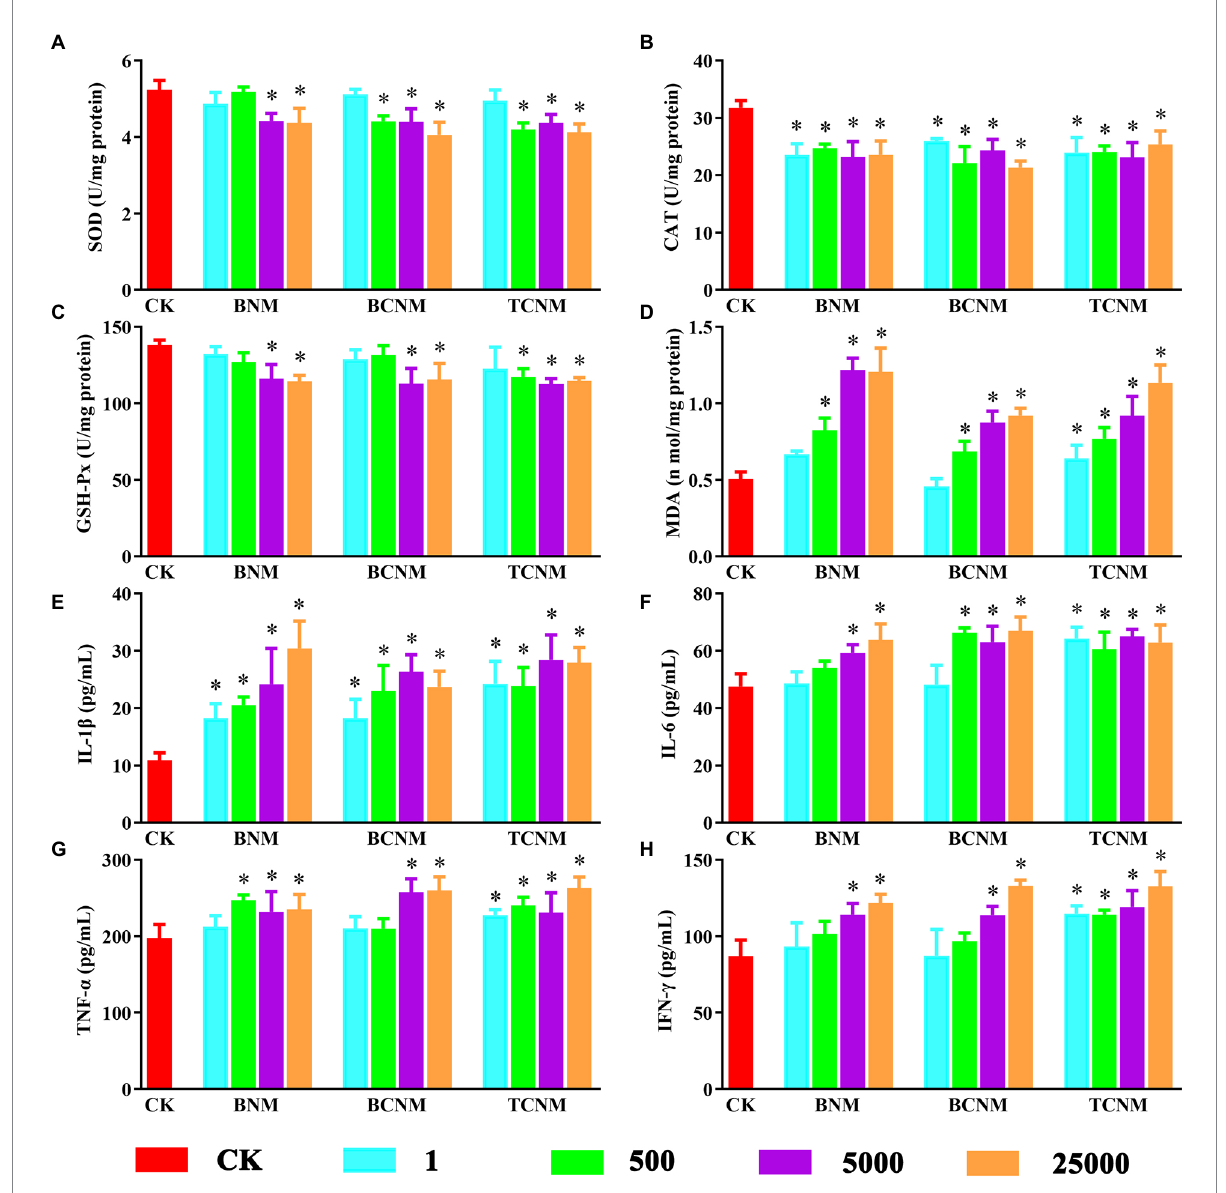
FIGURE 1 Effects of HNMs at different exposure concentrations ( μ g L − 1 ) on the antioxidant capacity and pro-inflammatory cytokine levels in mouse small intestine. (A) SOD, (B) CAT, (C) GSH-Px, (D) MDA, (E) IL-1 β , (F) IL-6, (G) TNF- α , and (H) IFN- γ . Values are mean values ± standard deviation ( n = 5). Differences were calculated using one-way ANOVA followed by Tukey’s post hoc test. * means significant difference compared to CK group ( p <